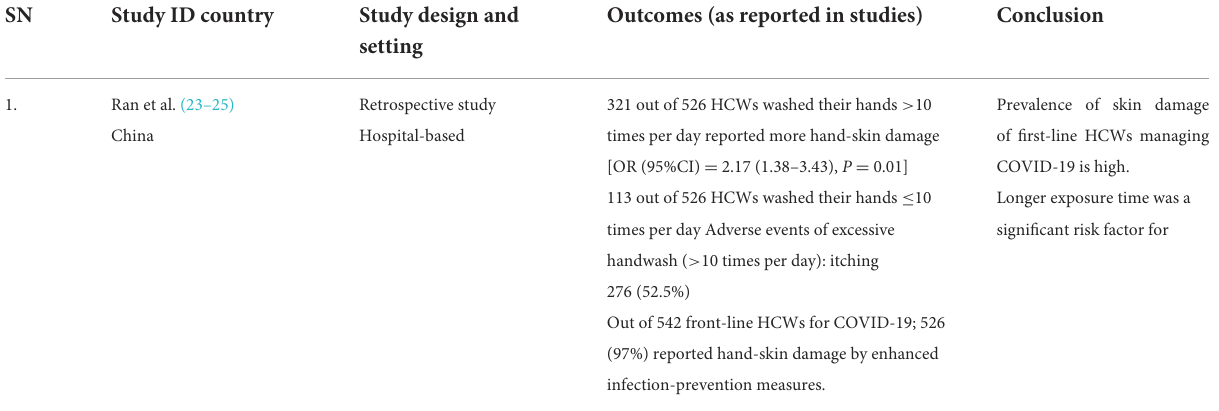
TABLE 5 Results of included studies table (Direct evidences on COVID-19 for secondary outcome of adverse events).